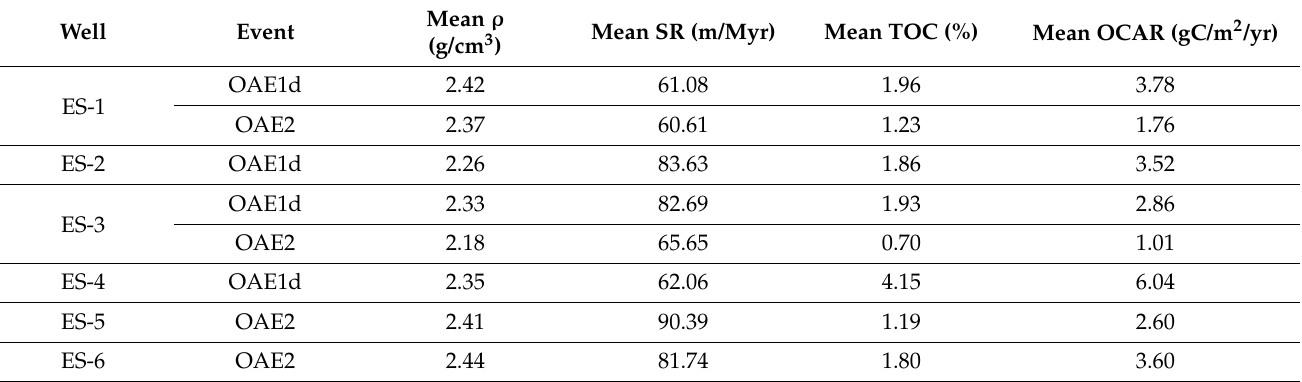
Table 1. Table showing the mean values of ρ (g/cm 3 ), SR (m/Myr), TOC (%), and OCAR (gC/m 2 /yr) for each event and